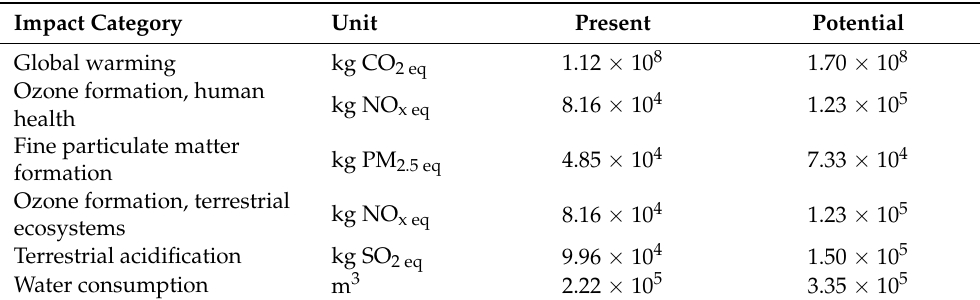
Table 6. Characterized ReCiPe midpoint impacts avoided by the present and the possible tree coverage in the Metropolitan City of